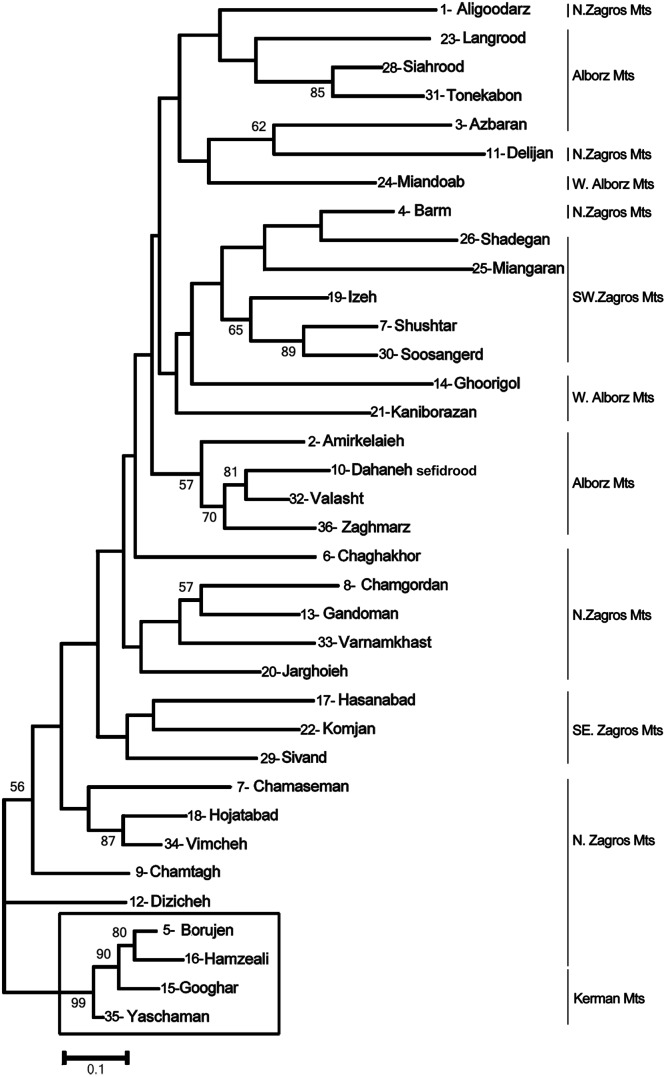
Neighbor joining tree of microsatellite diversity in 36 sites of P. pectinatus.